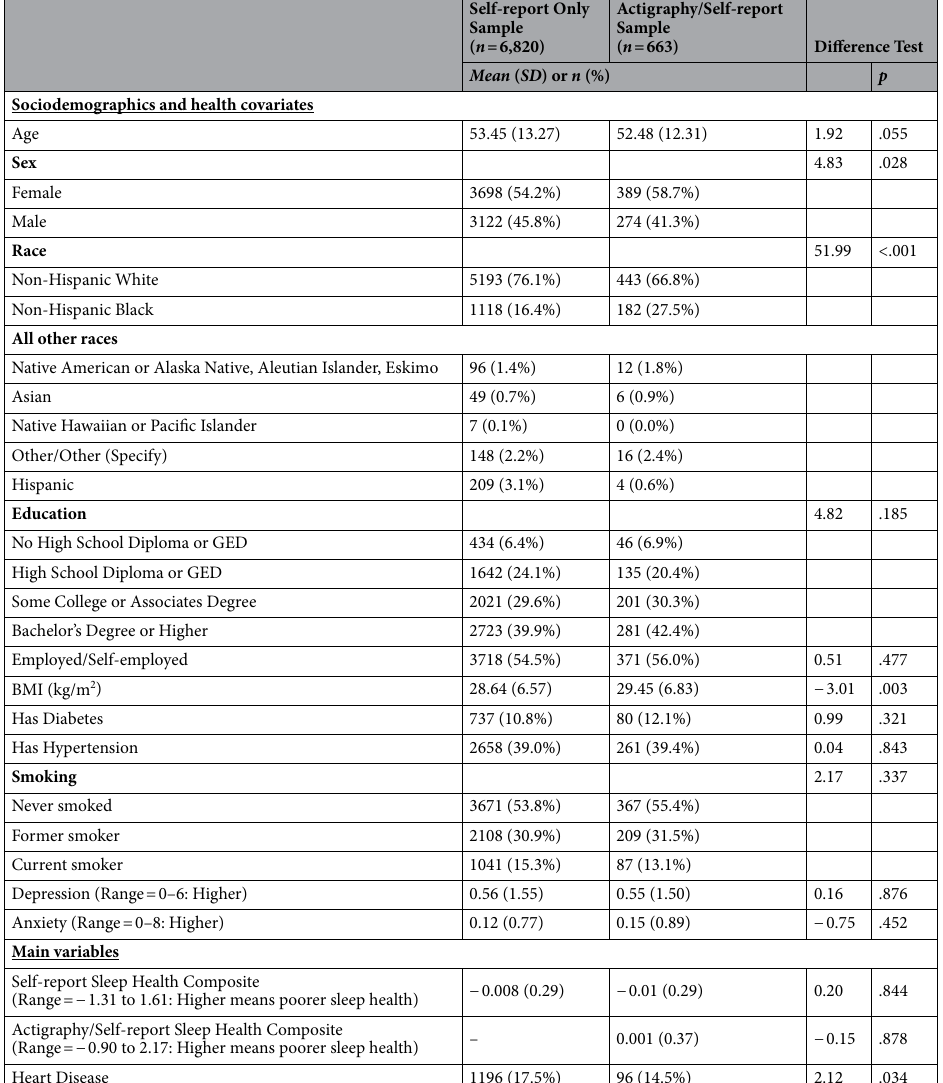
Table 4. MIDUS sample characteristics and descriptive statistics. The self-report only sample had less females, more non-Hispanic White and less non-Hispanic Black individuals, lower BMI, and higher prevalence of heart disease compared to the actigraphy/self-report